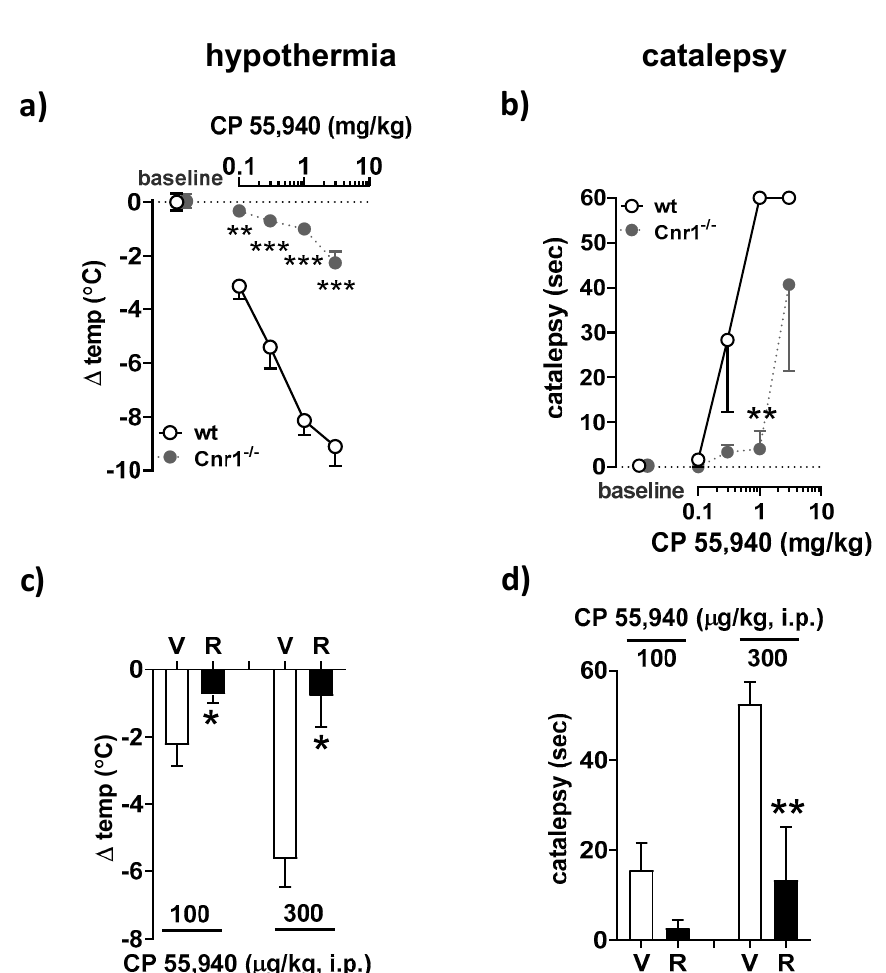
Figure 1. Effect of central administration of rimonabant on CP 55,940-induced catalepsy and hypothermia in mice. ( a , b ) Pharmacologically naïve Cnr1 − / − (ko) mice and wild-type littermates (wt) were injected with CP 55,940 (0.1, 0.3, 1 and 3 mg/kg; i.p.) at 30 min intervals. Body temperature ( a ) and cataleptic behavior ( b ) were evaluated before administering the next dose of CP 55,940. The respective baseline body temperature in wt and ko groups prior to CP 55,940 injection were 37.1 ± 0.3 ◦ C ( n = 3) and 37.2 ± 0.3 ◦ C ( n = 3). Mice held the bar for 0.3 ± 0.3 s and 0.3 ± 0.3 s in wt and ko groups, respectively. ( c , d ) Conscious freely moving C57BL/6J mice ( n = 5 animals per treatment group) were infused intracerebroventricularly (i.c.v.) with rimonabant (2 µg, R) or its solvent (V), followed 30 min later by intraperitoneal (i.p.) injection of CP 55,940 (0.1 or 0.3 mg/kg). Another 30 min passed before the hypothermic ( c ) and cataleptic ( d ) responses were measured. The respective baseline body temperatures before CP 55,940 injection to V- and R-infused groups were 37.6 ± 0.1 ◦ C and 37.5 ± 0.1 ◦ C ( n = 10). Mice held the bar for 0.3 ± 0.3 s and 0.1 ± 0.1 s in V- and R-treated groups, respectively. Results are means ± s.e.m. ** p < 0.01, *** p < 0.01 compared to Cnr1 − / − mice ( a , b ); * p < 0.05, ** p < 0.01 compared to vehicle ( c , d